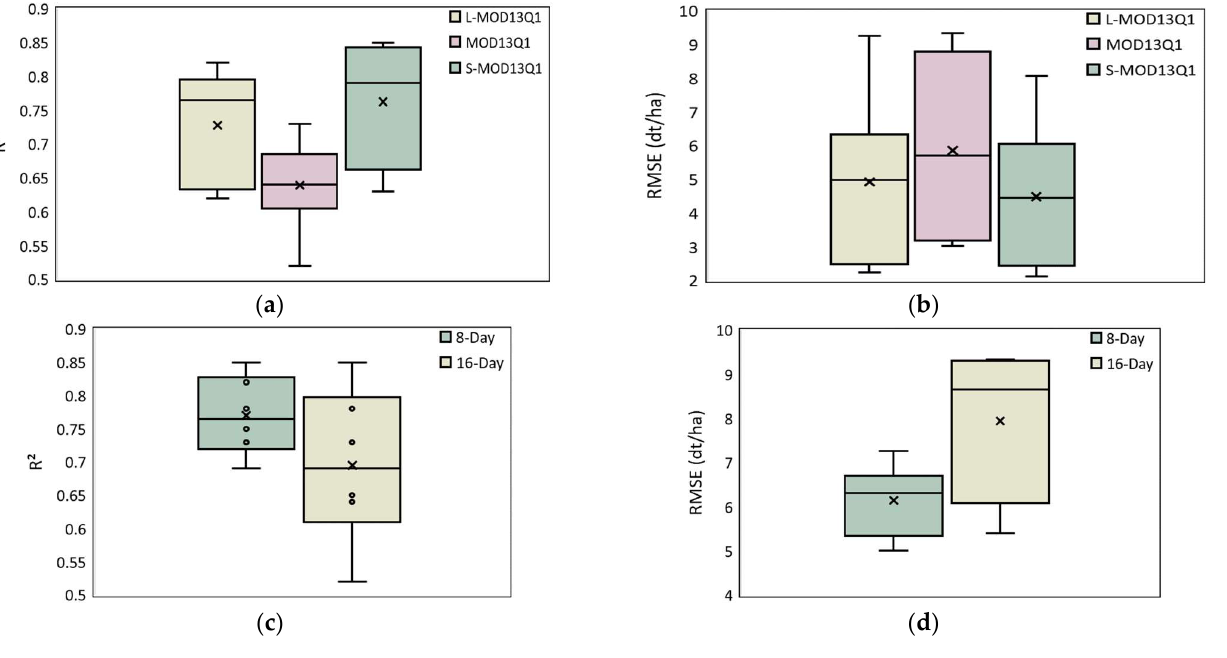
Figure 9. The box plots compare the accuracies ( a , c ) R 2 and ( b , d ) RMSE of referenced (at 95% confidence interval) and modelled yields obtained from multi-source data: MOD13Q1, L-MOD13Q1, and S-MOD13Q1 at temporal scales of 8 and 16